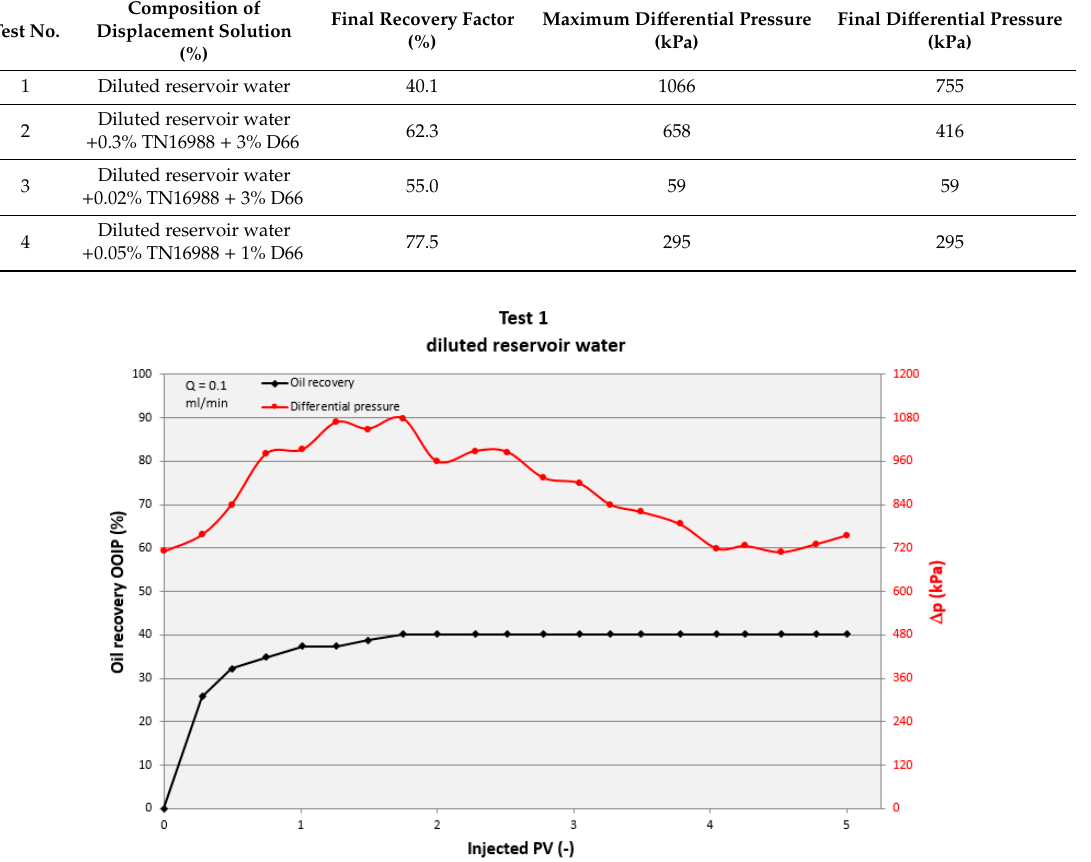
Figure 4. Recovery factor for diluted reservoir water.